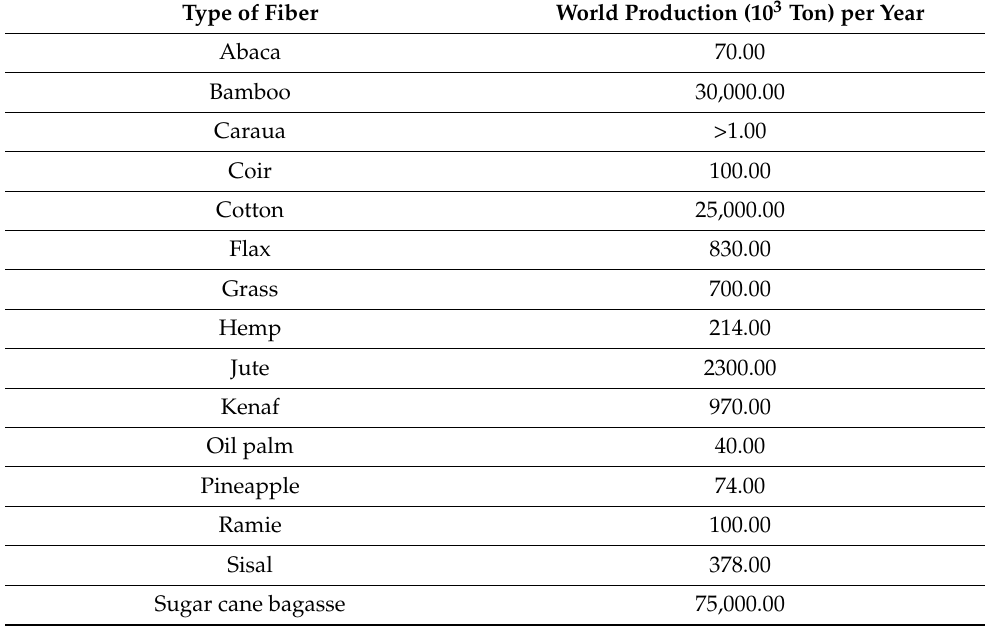
Table 1. World production per year of natural fibers [16,18,19]. Copyrights with permission from Elsevier